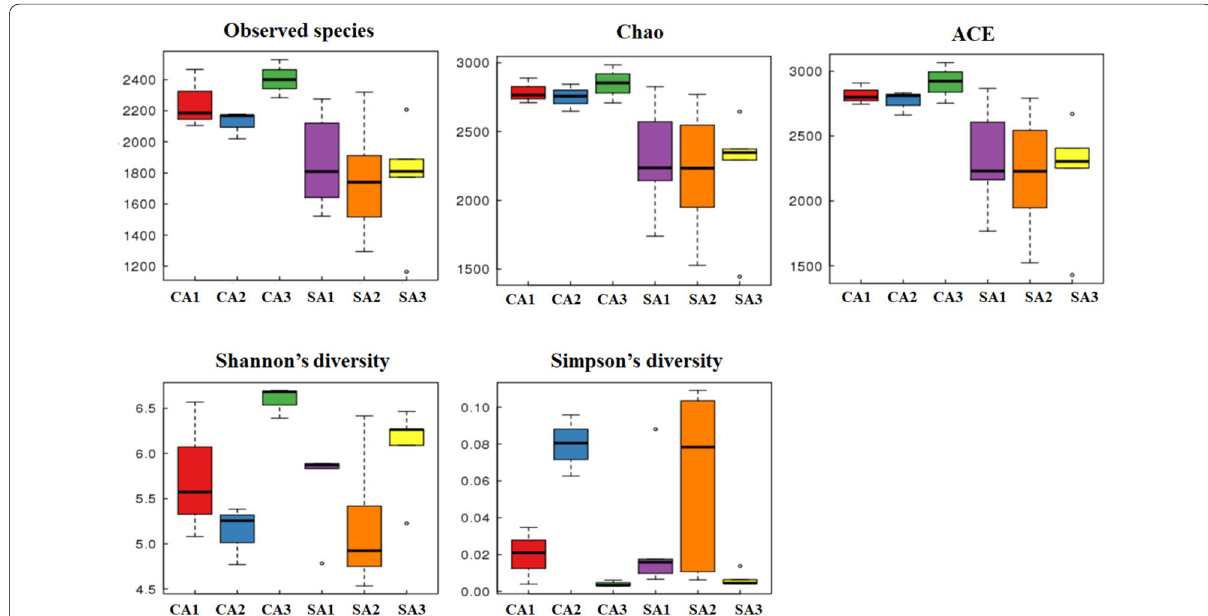
Fig. 4 Temporal variations in the alpha diversity indices of soil bacteria inhabiting the litchi orchards that were maintained under conventional (CA) and sustainable (SA) agricultural practices. 1, 2 and 3 indicate successive trimester samplings carried out on October 2016, January 2017 and April 2017, respectively. The indices were calculated by Mothur (v1.31.2) and graphs were generated by the R software